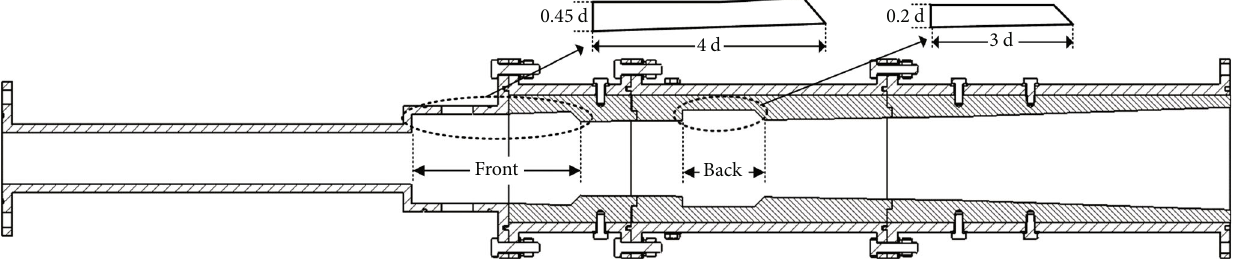
Figure 5: Schematic of the cavity position and